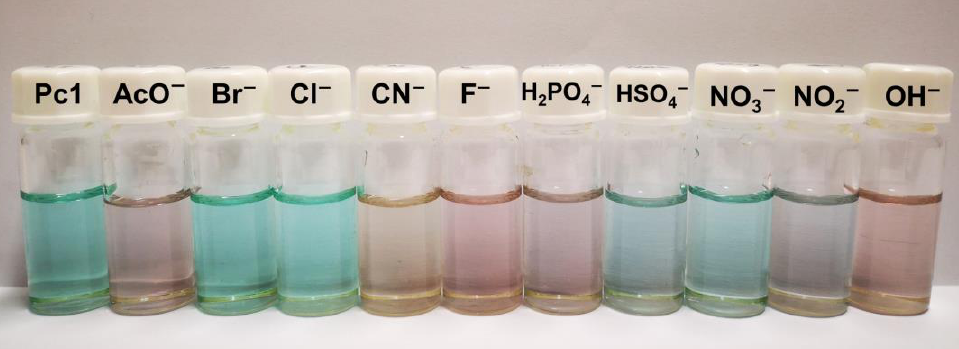
Figure 4. Changes in the color solutions of Pc1 in DMSO upon the addition of different anions (as TBA salts) in DMSO.